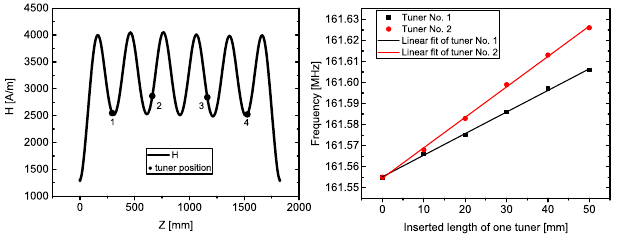
18. The left-hand side shows the magnetic field along the RFQandthetunerpositions.Theright-handsideshowsthefrequency shift as a function of the inserted depth of no. 1 and no. 2 tuners.